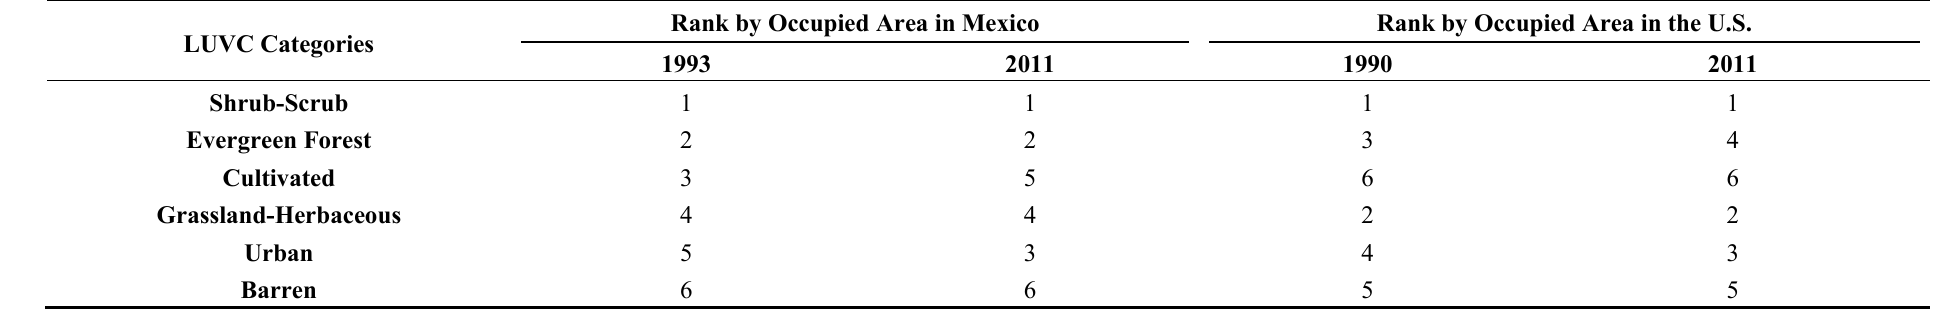
Table 4. Rank by occupied surface of LUVC categories with greatest changes. Shaded cells indicate LUVC categories with greatest surface changes. LUVC